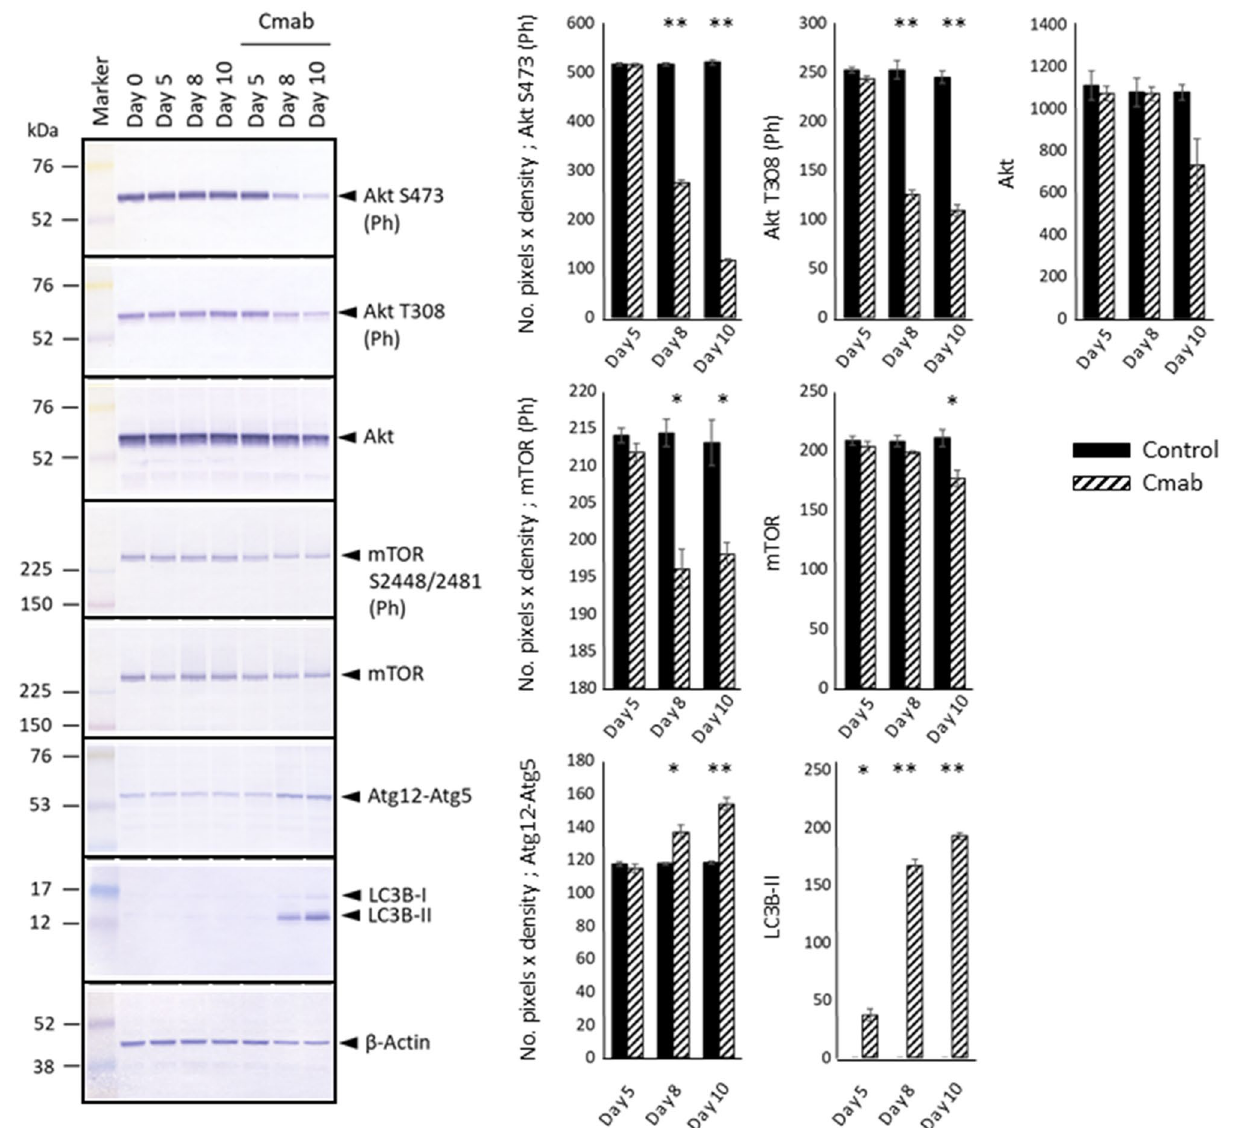
Figure 8. Examination of the Akt–mTOR pathway, which controls Skp2 activation. WB analysis revealed that cetuximab treatment (10 µg/mL) potently inhibited Akt phosphorylation at S473 and T308, which are related to Akt activation. In addition, cetuximab treatment suppressed mTOR phosphorylation at S2448 and S2481, which are related to mTOR activation. The expression levels of Atg12–Atg5 and LC3Bs, which are associated with autophagy, were also analyzed, which revealed markedly increased expression of the Atg12–Atg5 complex and type-II LC3B in cells treated with cetuximab for 8 or 10 days. Those expression levels were evaluated with the number of pixels × density and analyzed with t test (control- versus cetuximab-treated group). The experiment was repeated 3 times. * p < 0.05, ** p <